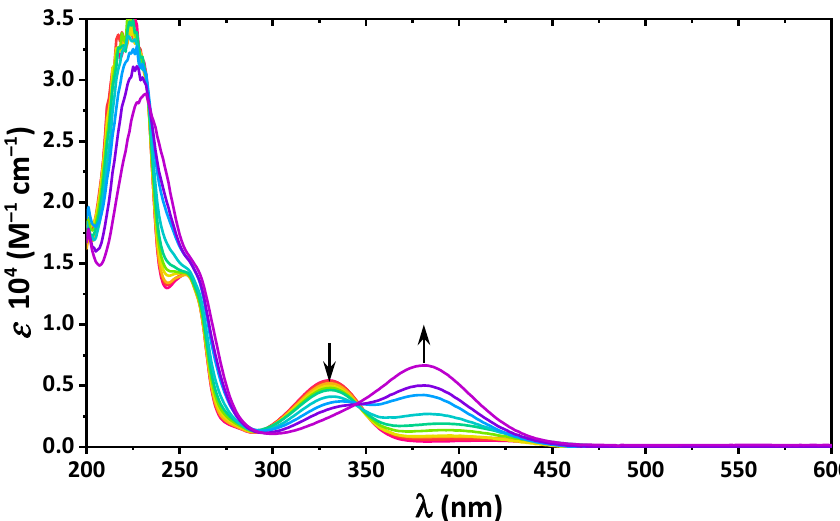
Figure 6. UV-vis spectra of 3 in EtOH upon gradual addition of NaOH up to 5 eqv., with a step of 0.5 eqv.